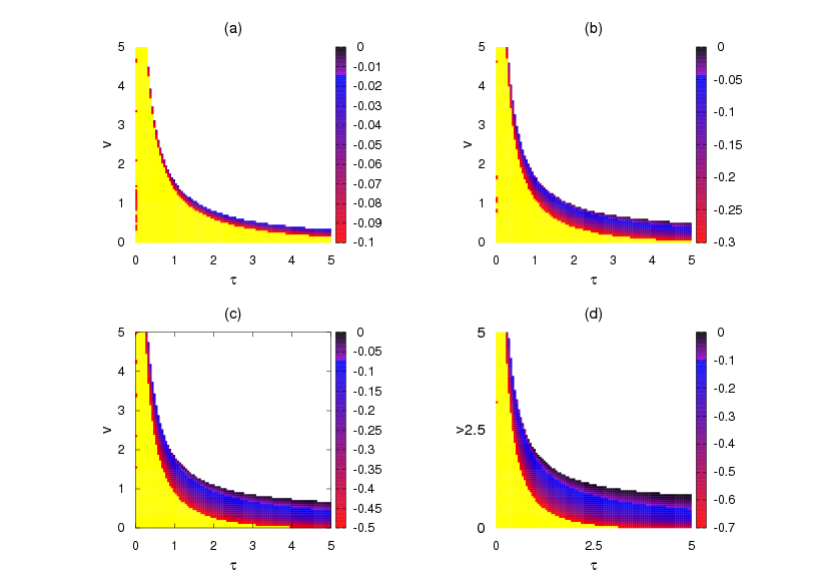
Figure 2: Stability charts: (a) µ = 0 . 1 , (b) µ = 0 . 3 , (c) µ = 0 . 5 , (d) µ = 0 . 7